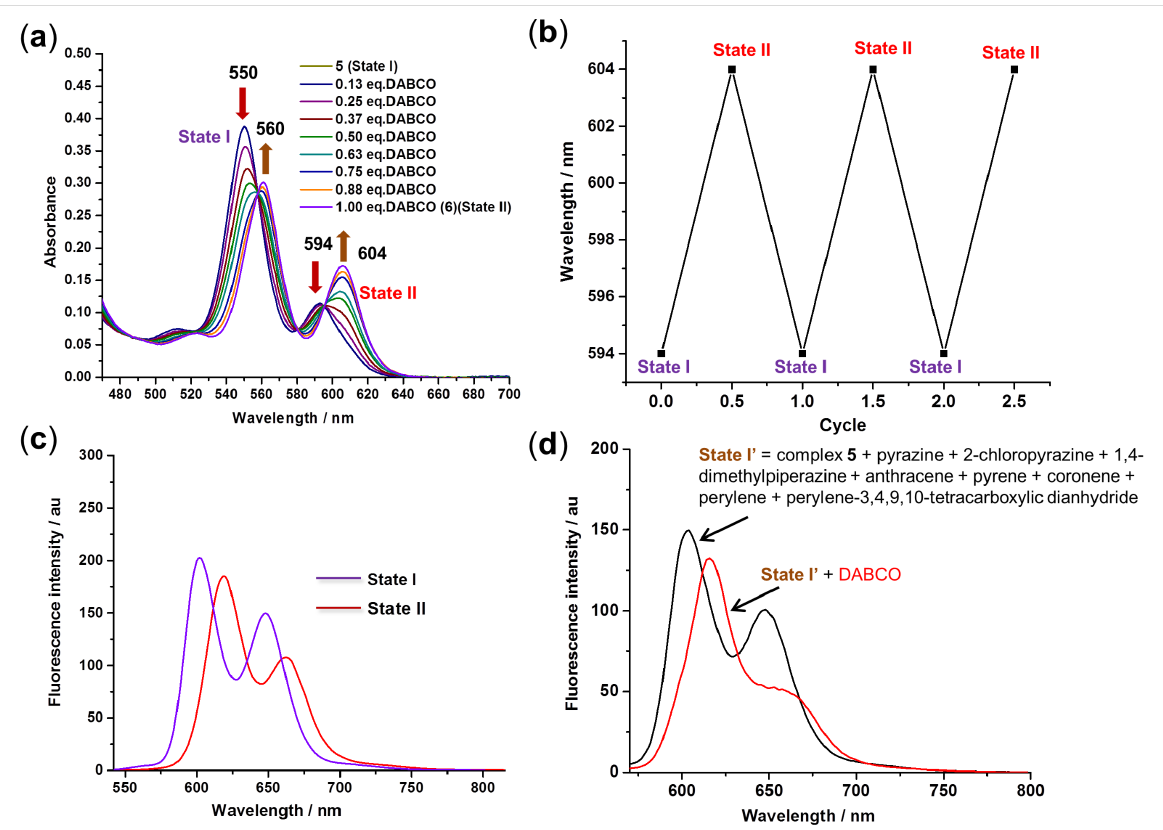
Figure 3: (a) UV–vis titration of rectangle 5 (2.98 μ M) with DABCO ( 4 ); (b) several reversible cycles of interconversion monitored at λ = 594 and 604 nm; (c) emission spectra of states I and II ( λ exc = 557 nm); (d) emission spectra of 5 ( λ exc = 557 nm) after adding various potential